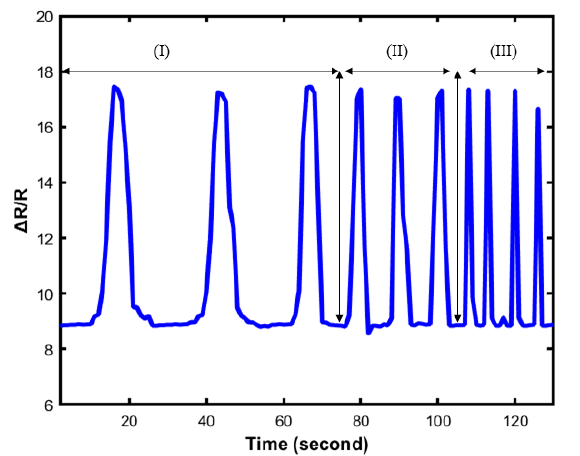
Figure 12. Resistance change under 3 different loading frequencies at 0.020 Hz, 0.08 Hz, and 0.012 Hz marked as region I, II and III